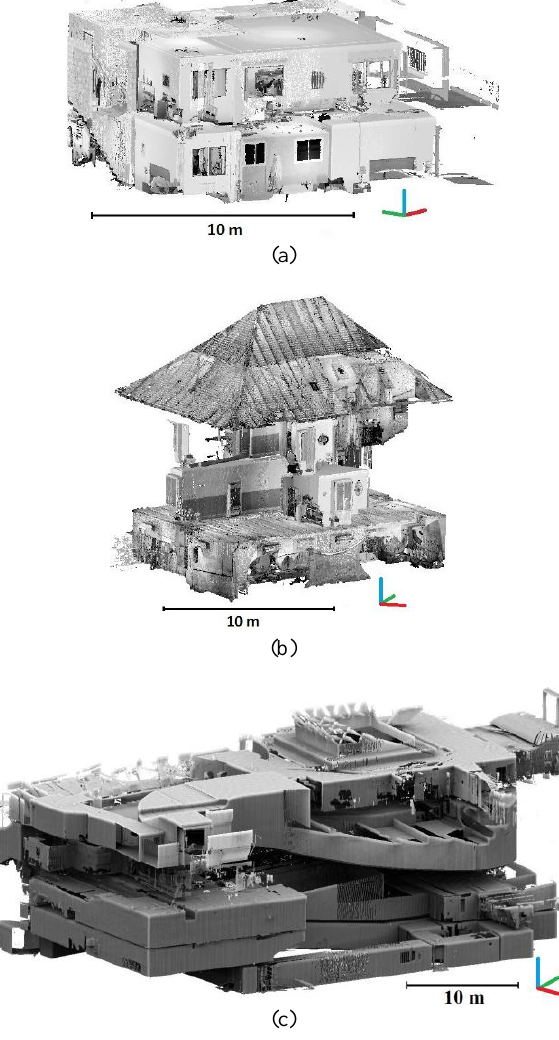
Figure 7. Indoor point clouds spatially resampled at 1 cm: (a) individual house No.1 (~10M points); (b) individual house No.2 (~34M points); (c) Haussmann building (~60M